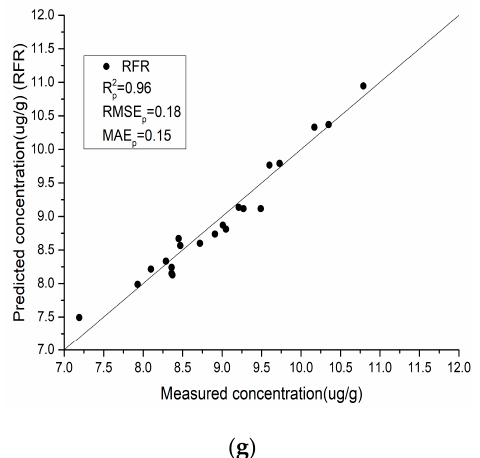
Figure 7. A comparison between the measured values and predicted values of the different regression models using laboratory spectra. ( a ) Partial least squares regression (PLSR); ( b ) Bayesian ridge regression (BRR); ( c ) ridge regression (RR); ( d ) kernel ridge regression (KRR); ( e ) support vector machine regression (SVMR); ( f ) eXtreme gradient boosting (XGBoost) regression; ( g ) random forest regression (RFR).